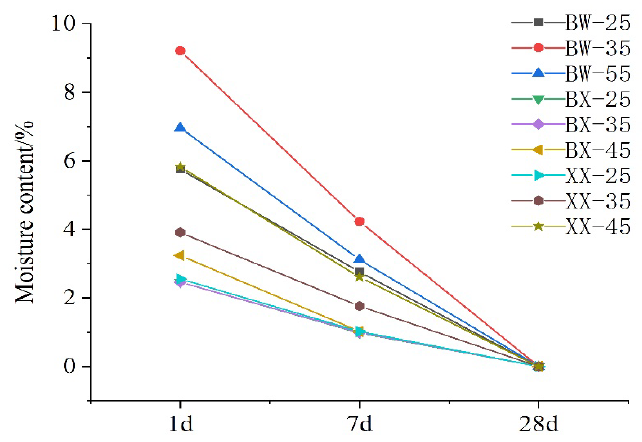
Figure 5. Relationship between test specimen moisture content and measurement time.